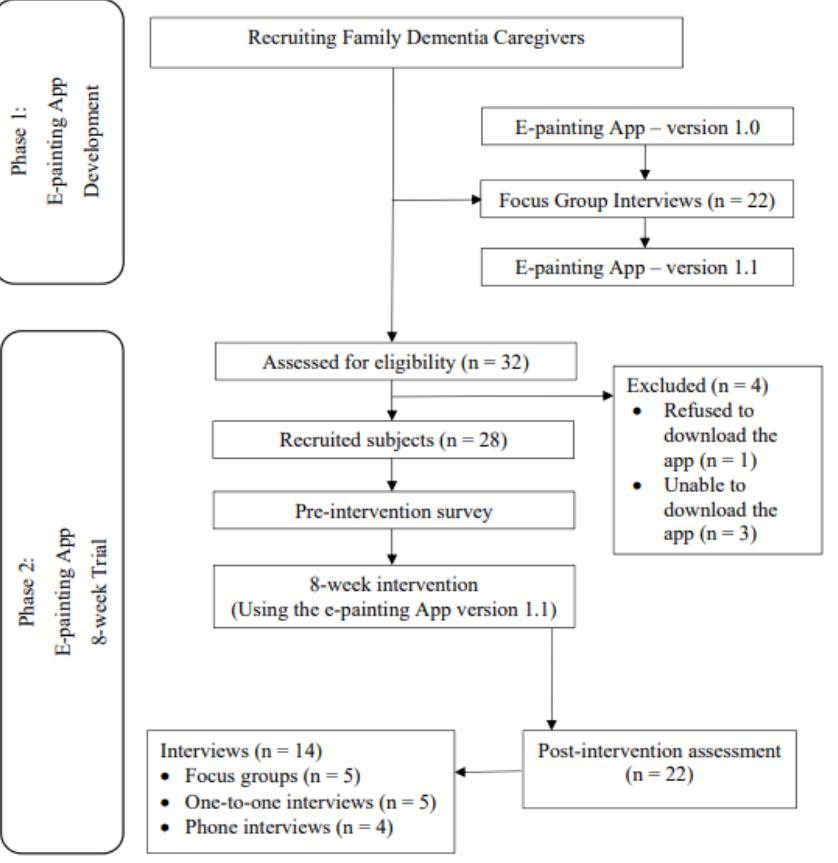
Figure 1. Flowchart Diagram.